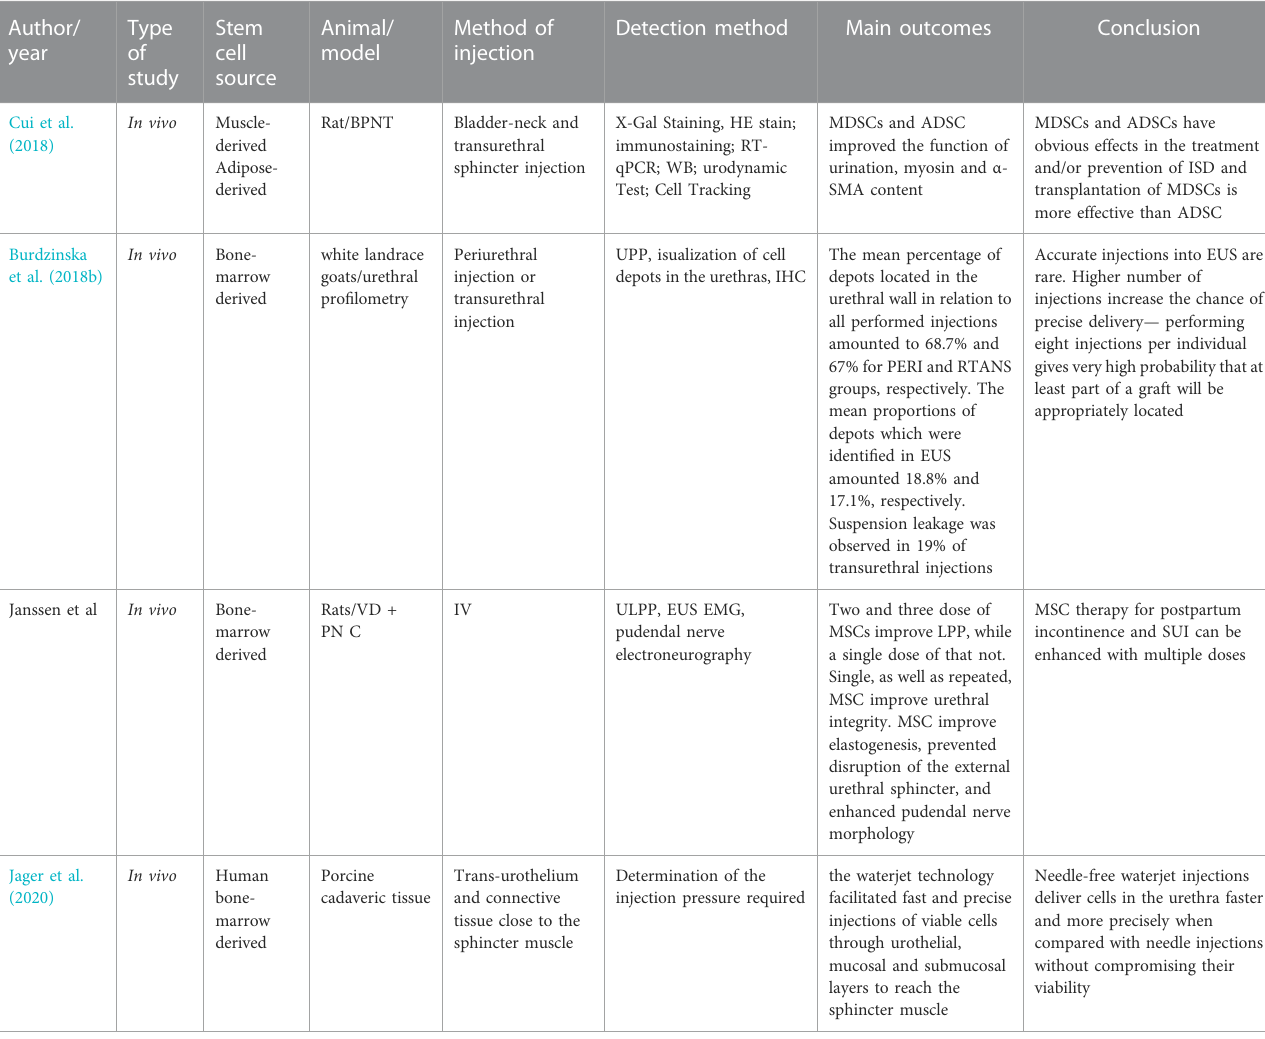
TABLE 4 Characteristics of the study of MSC therapy for SUI in other aspects.